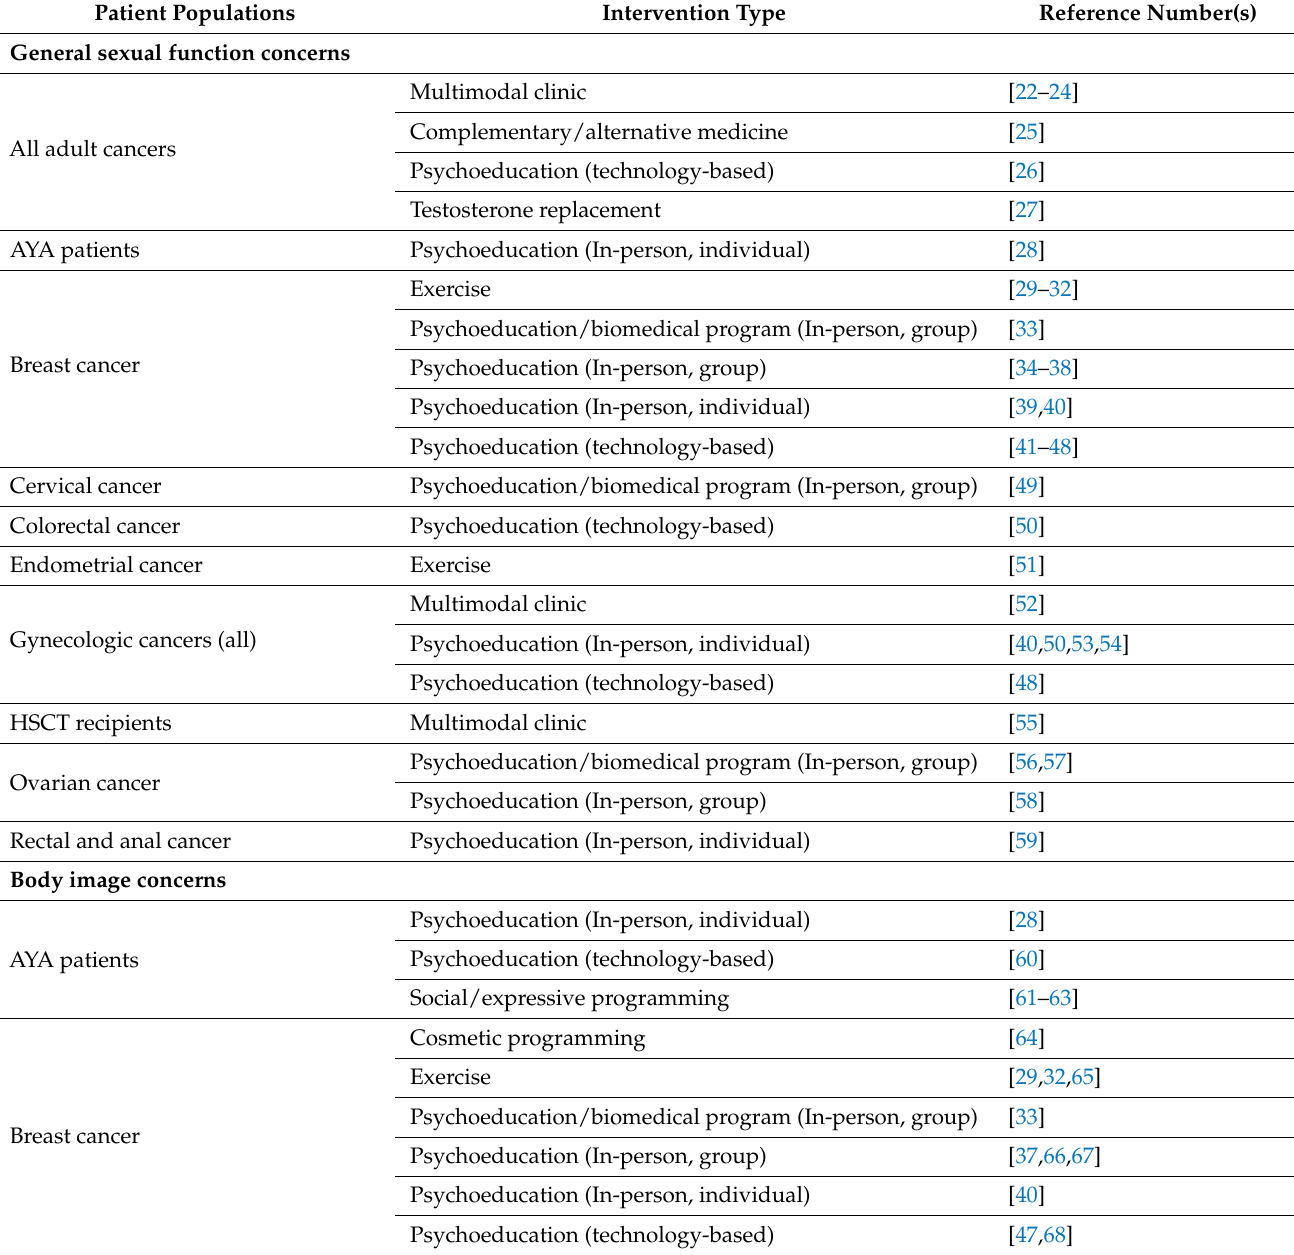
Table 1. Interventions for general sexual function and body image